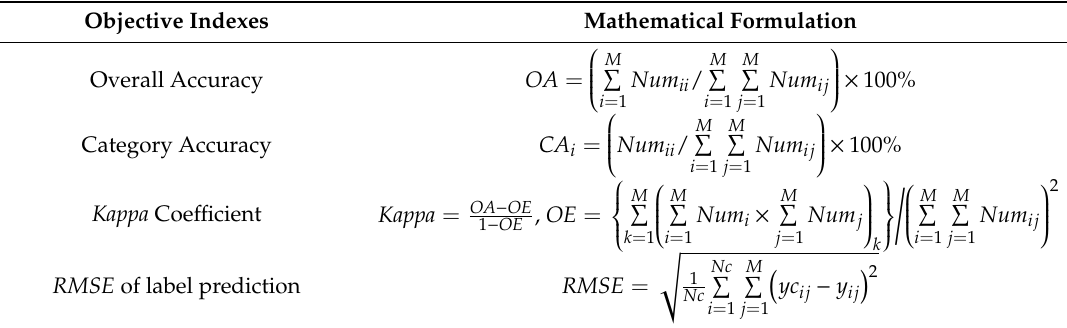
Table 1. Mathematical descriptions of objective indexes for sediment